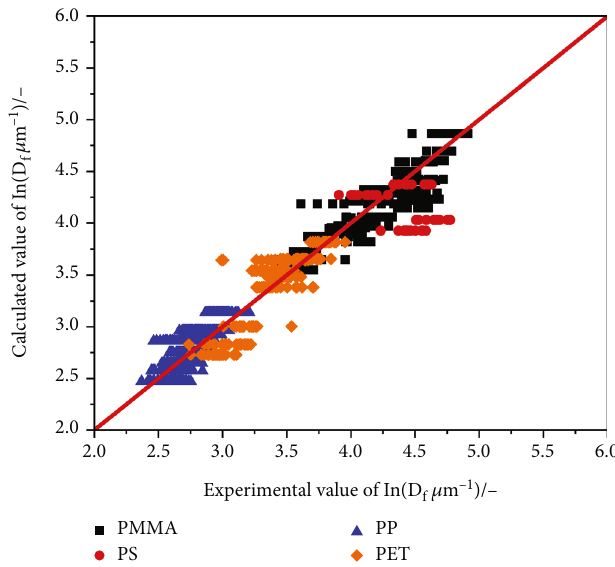
Figure 11: Comparison of the predicted and measured fi bre diameters using the fi xed output parameter values given in equation (5).